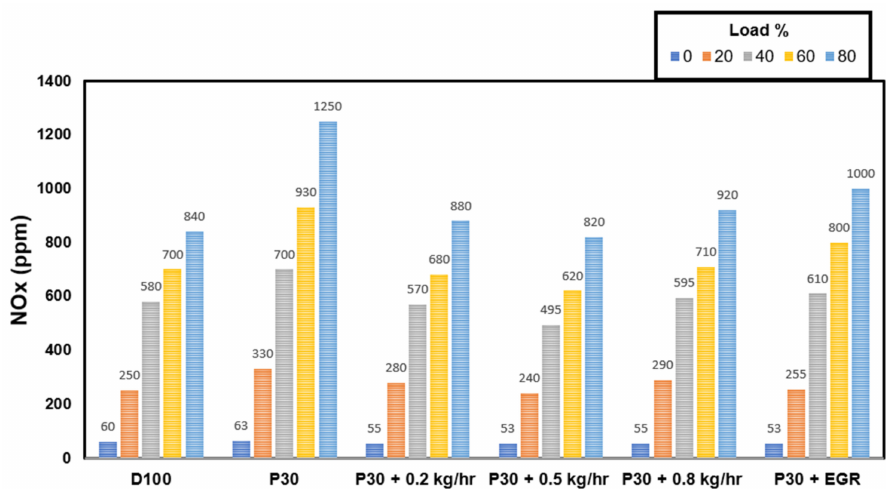
Figure 3. NOx variation with load